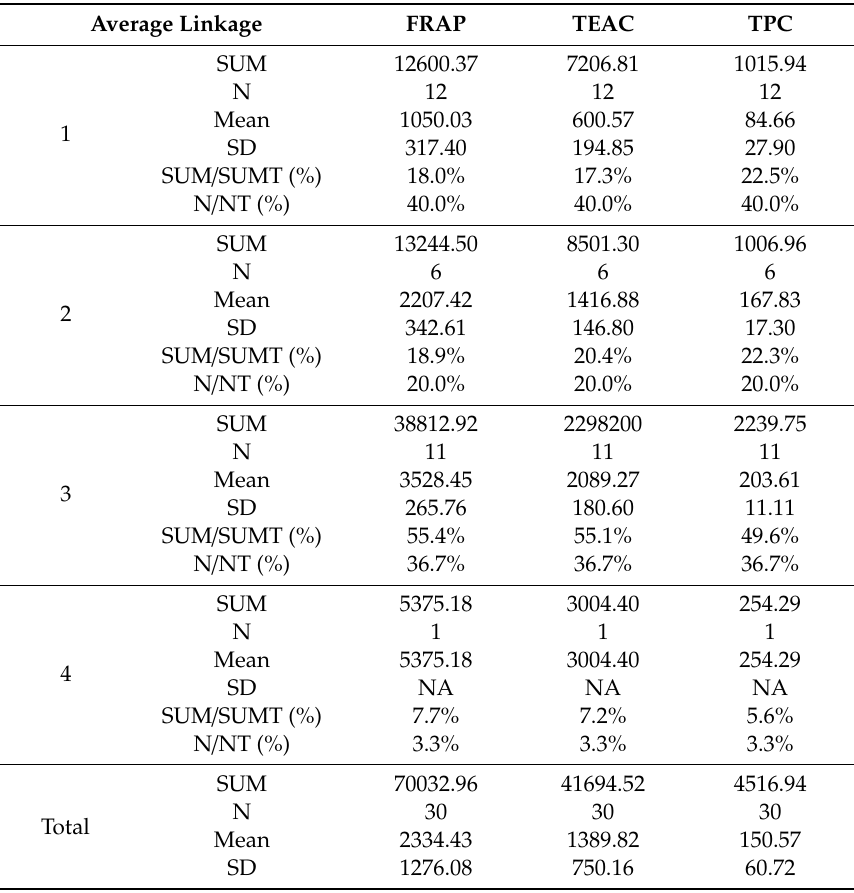
Table 6. Online Analytical Processing (OLAP) Cube based on systematic cluster analysis for 30 Chinese teas (cluster number =